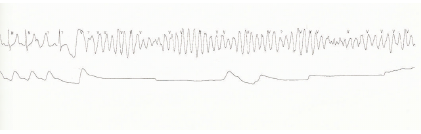
Figure 2: Rhythm strip showing torsades de pointes.